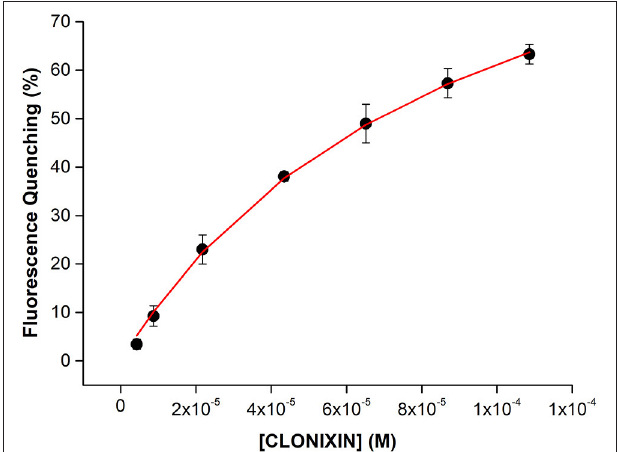
FIGURE 9 | HSA fluorescence quenching (%) as a function of increasing Clonixin concentrations (4.3 × 10 − 6 , 8.7 × 10 − 6 , 2.2 × 10 − 5 , 4.3 × 10 − 5 , 6.5 × 10 − 5 , 8.7 × 10 − 5 , and 1.1 × 10 − 4 M). A non-linear fit according to Equation 12 is presented. Experimental data is presented as average value ± standard deviation of 3 independent assays).